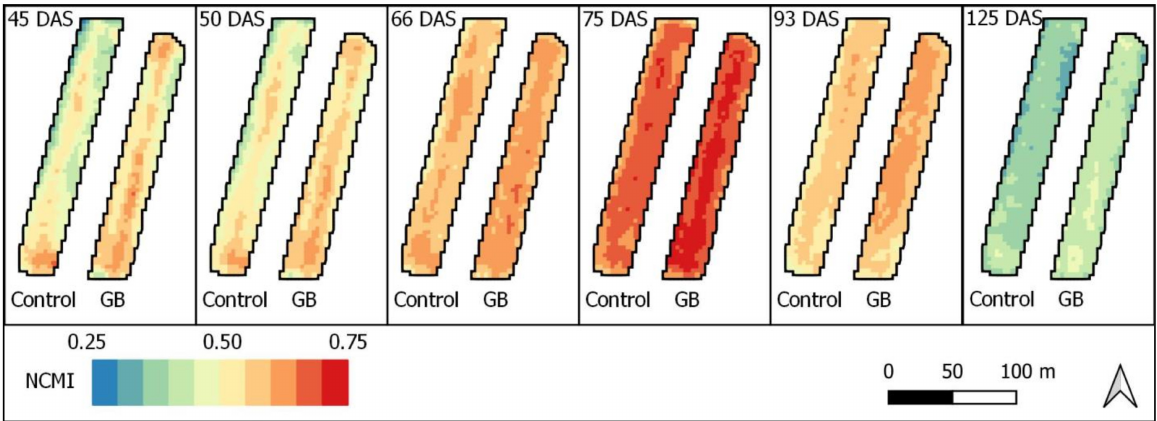
Figure 11. Spatial distribution of NCMI values at 3 m spatial resolution for each date analyzed. Arrow indicate the proper